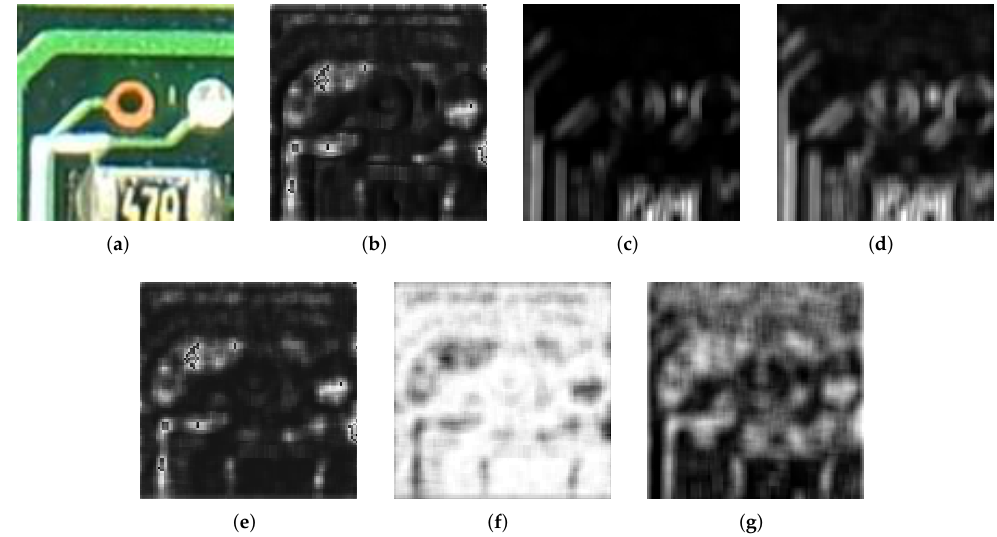
Figure 10. ( a ) A part of the original PCB image; ( b ) ASM image when θ = 0 ◦ , ( c ) contrast image when θ = 0 ◦ ; ( d ) dissimilarity image when θ = 0 ◦ ; ( e ) energy image when θ = 0 ◦ , ( f ) entropy image when θ = 0 ◦ ; and ( g ) homogeneity image when θ = 0 ◦ . These six images are different